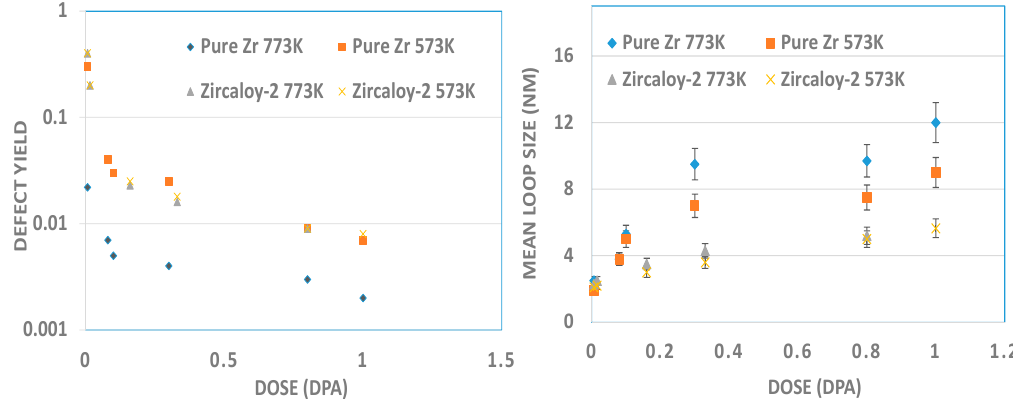
Figure 4. Mean loop size and defect yield in Zircaloy-2 plotted as a function of dose at both irradiation temperatures, compared with pure Zr.